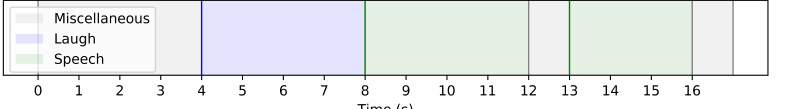
Figure 9. Sound event classification performed on the whole sound sample with three classes: speech, laughter and